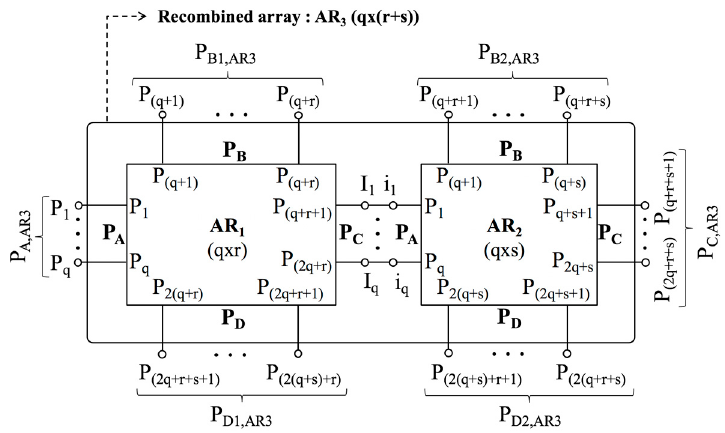
Figure 6. A block diagram for the recombination of two sub-domains including multiple ports.